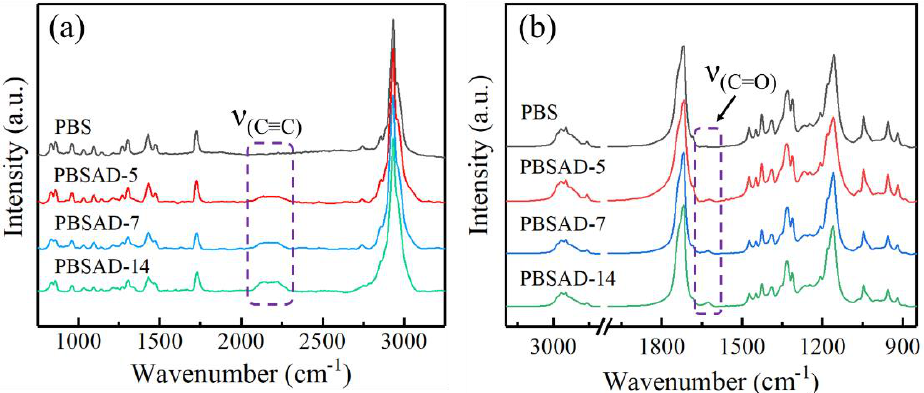
Figure 2. ( a ) Raman spectra and ( b ) FTIR spectra of PBS and